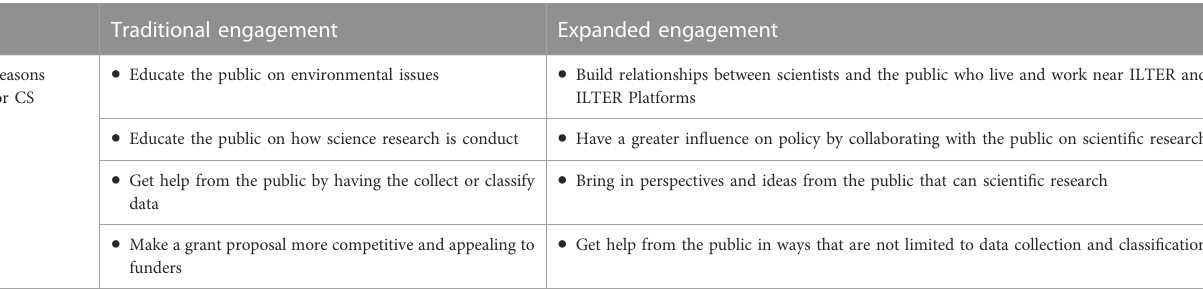
TABLE 1 List of the reasons for participating in CS activities, considering traditional and expanded engagement. Traditional engagement Expanded